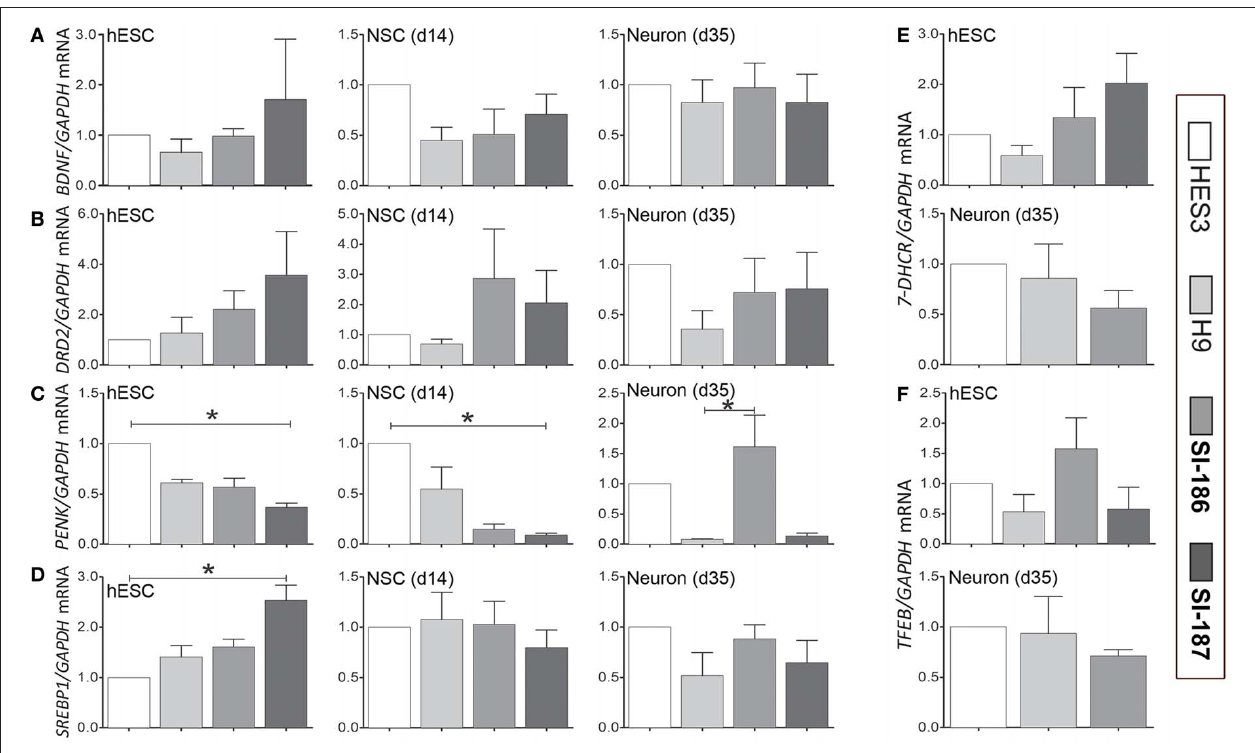
stage (d0), mid-neurosphere stage (d14) and neuronal differentiation stage (d35). Transcripts are assessed for (A) BDNF , (B) DRD2 , (C) PENK , (D) SREPB1 , (E) 7-DHCR, and (F) TFEB . One-Way ANOVA, ∗ p < 0 .